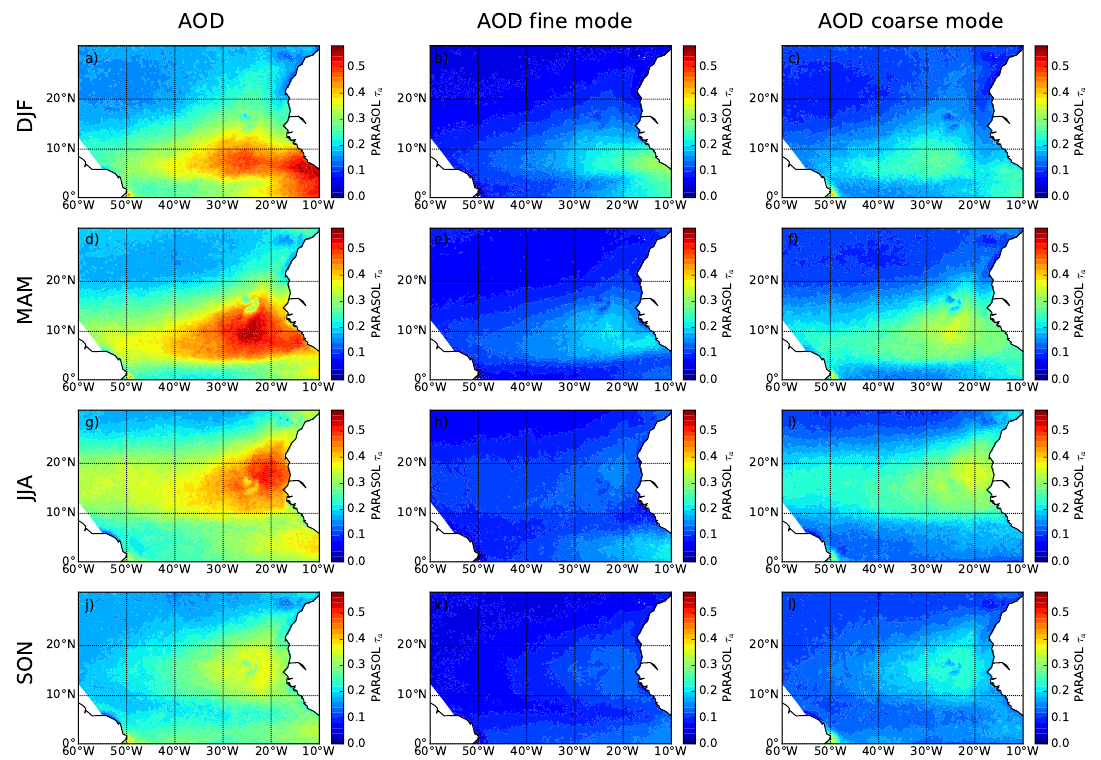
Figure 7. Spatial distribution of PARASOL AOD seasonal mean (2005–2013) at 550 nm: ( a – c ) winter mean (DJF), ( d – f ) spring mean (MAM), ( g – i ) summer mean (JJA) and ( j – l ) autumn mean (SON). The left column presents total AOD, the center column presents AOD f and the right column presents AOD c